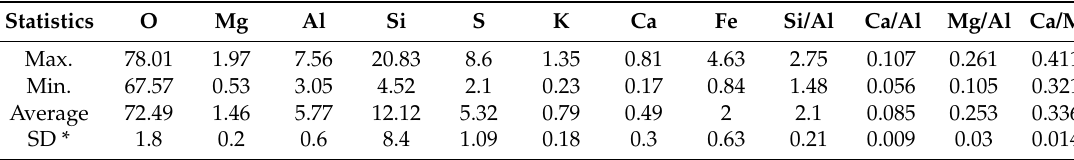
Table 2. Average chemical composition of MT-KSF sample by EDS analysis.